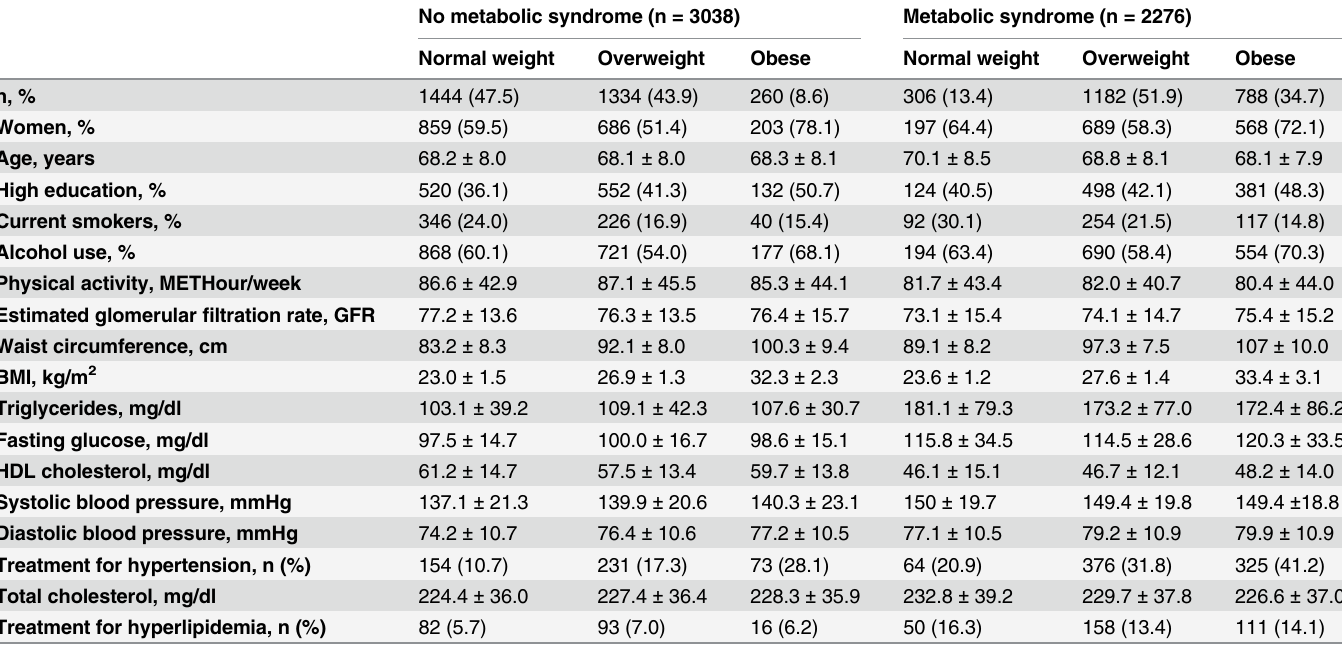
Table 1. Baseline characteristics of study population across the categories of metabolic health status and body mass